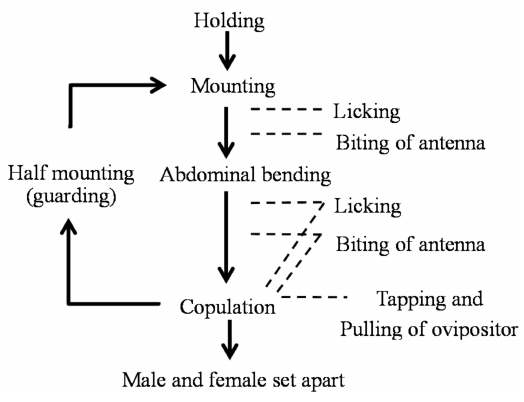
Figure 8. Ethogram of Rosalia batesi male and female in mating after firm contact.